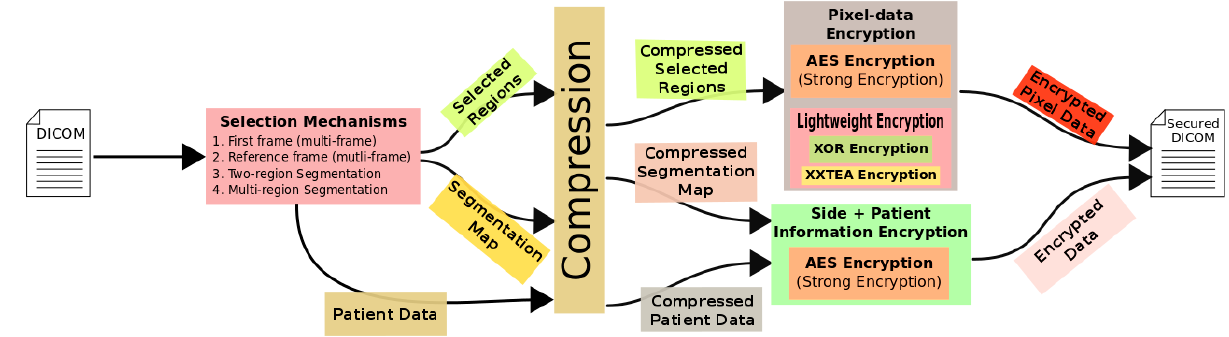
Figure 3. The fundamental concept of the proposed selective encryption process.